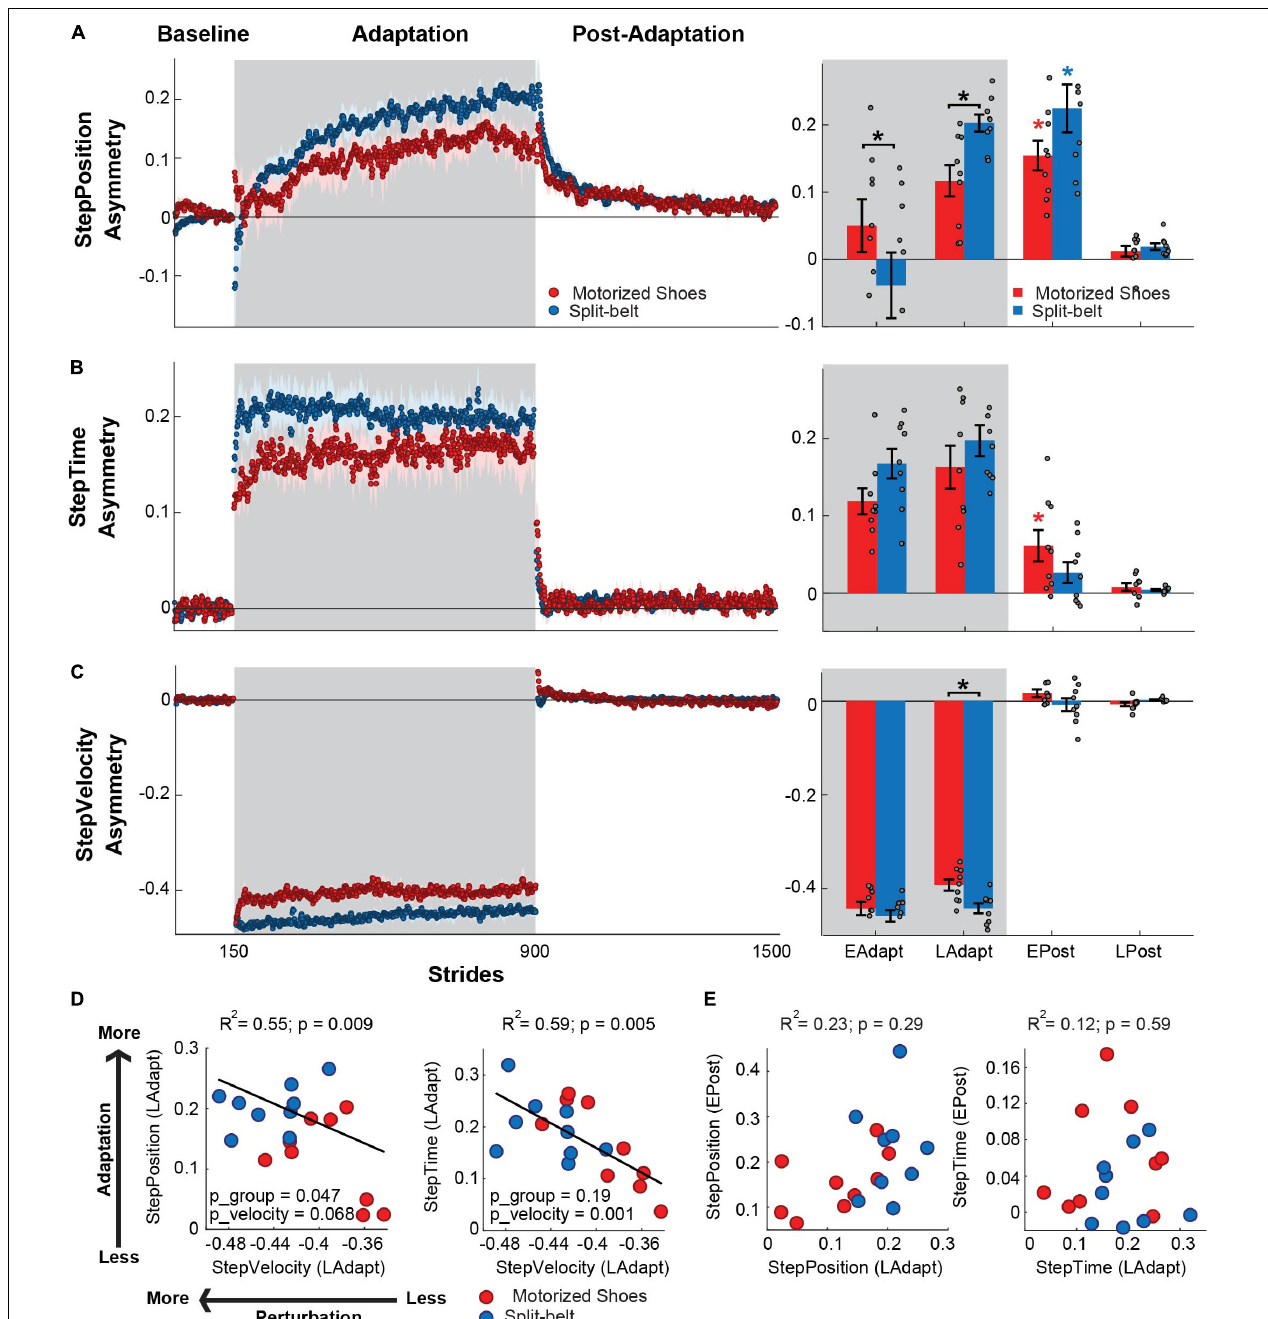
FIGURE 4 | Adaptation of spatiotemporal components of step length asymmetry. ( A–C , Left panel) Time courses for StepPosition, StepTime, and StepVelocity before, during, and after adaptation. Shaded gray area represents the adaptation period when the feet move at different speeds (“split” walking), whereas white areas represent when the feet move at the same speed. Colored dots represent the group average of five consecutive strides and colored shaded regions indicate the standard error for each group (motorized shoes: red; split-belt: blue). ( A–C , Right panel) The bar plots indicate the mean ± standard errors for StepPosition, StepTime, and StepVelocity for each group and epoch of interest. Gray dots represent individual participants. Note that the values were corrected for baseline biases. Significant differences for post hoc tests were indicated as follows. Black asterisks over the bracket above each epoch represent statistical significant differences between the motorized shoes and the split-belt groups ( p < 0.05). Colored asterisks over the bars indicate significant after-effects (i.e. early post-adaptation is significantly different from baseline; p < 0.05) for each of the groups (motorized shoes: red; split-belt: blue). (D) Scatter plots illustrate the association between the StepVelocity at steady state and either the StepPosition or StepTime at steady-state during adaptation (i.e. LAdapt). We present the p -values for the multiple regression model (p), for the continuous variable (StepVelocity, p_velocity) and for the categorical variable (group, p_group). (E) Scatter plots illustrate the association between the LAdapt and EPost for StepPosition and StepTime. No significant relations were observed for neither StepPosition nor StepTime.